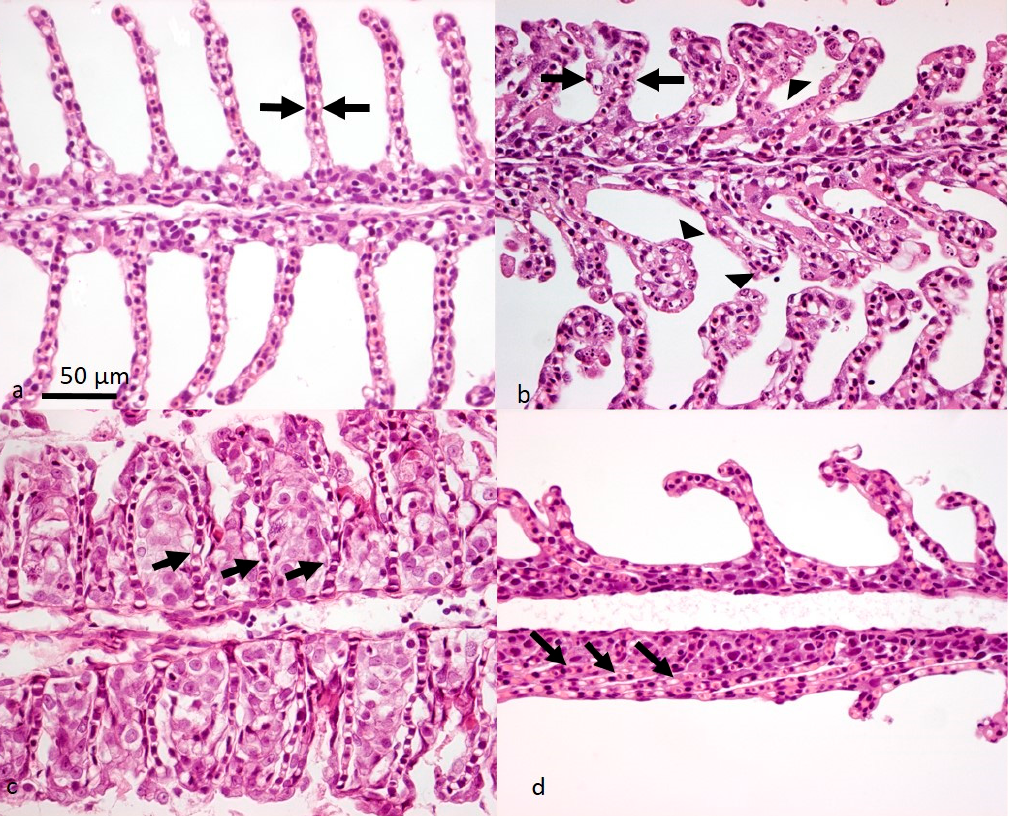
Figure 4. Three examples of SGPVD gill pathology leading to severely reduced functional respiratory surface area. ( a ) Normal gill histology shows thin lamellae (arrow) with normal epithelial cells narrowly separating blood and water. ( b – d ) SGPVD gill pathology i.e., ( b ) the extensive presence of apoptotic gill epithelial cells (arrowheads) containing SGPV, and lamella that have become thickened (arrows ). ( c ) Foamy epithelial cells fill the normally water-filled inter-lamellar space (arrows indicate lamellar vessels), and ( d ) possibly detached apoptotic cells with associated loss of surface charge, leading to lamellar adhesion (arrows ).